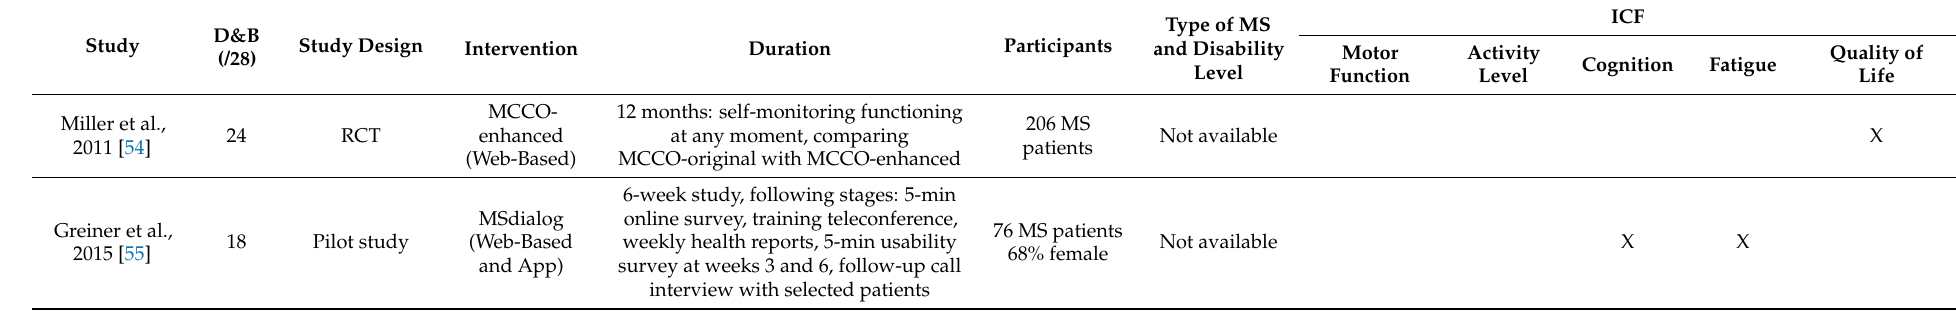
Table 2. Characteristics of the included studies (study design, mean duration on the intervention, targeted ICF function) on mHealth for self-assessment and description of the participants.